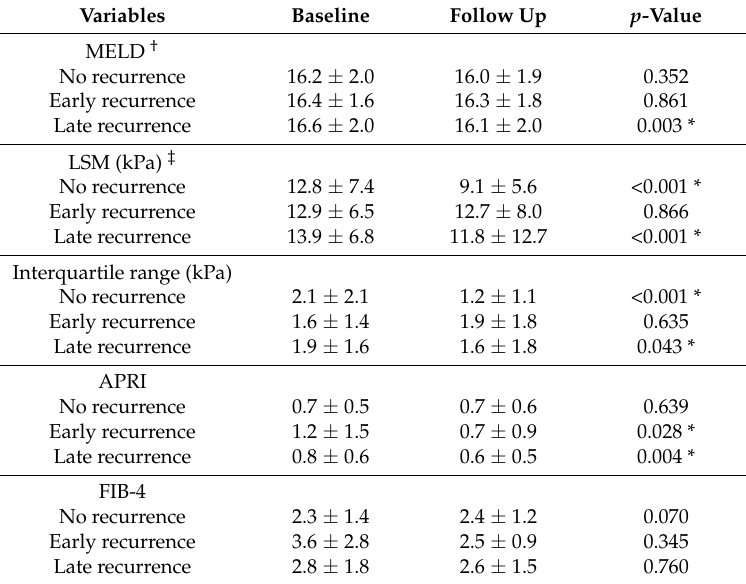
Table 2. Changes in noninvasive parameters of fibrosis during follow-up.